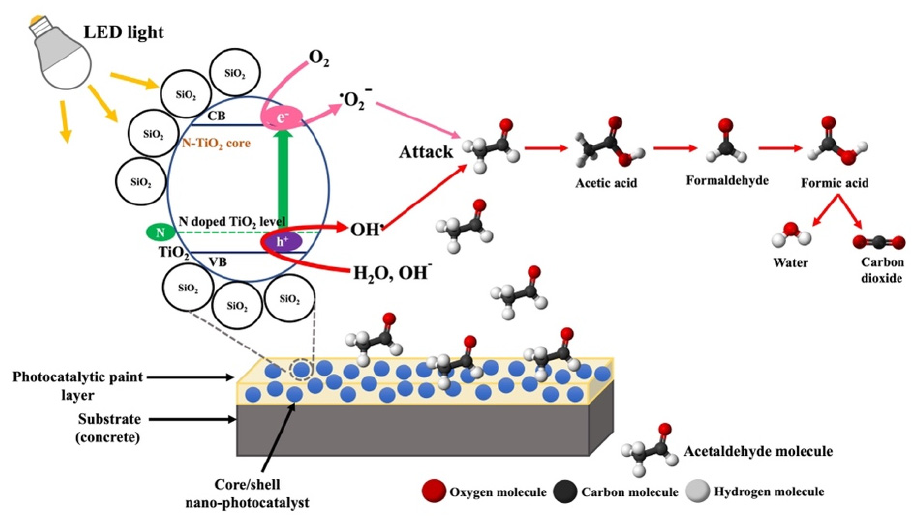
Figure 11. Schematic illustration of a photocatalytic mechanism for decomposition of gaseous acetaldehyde by N-TiO 2 @SiO 2 paint .